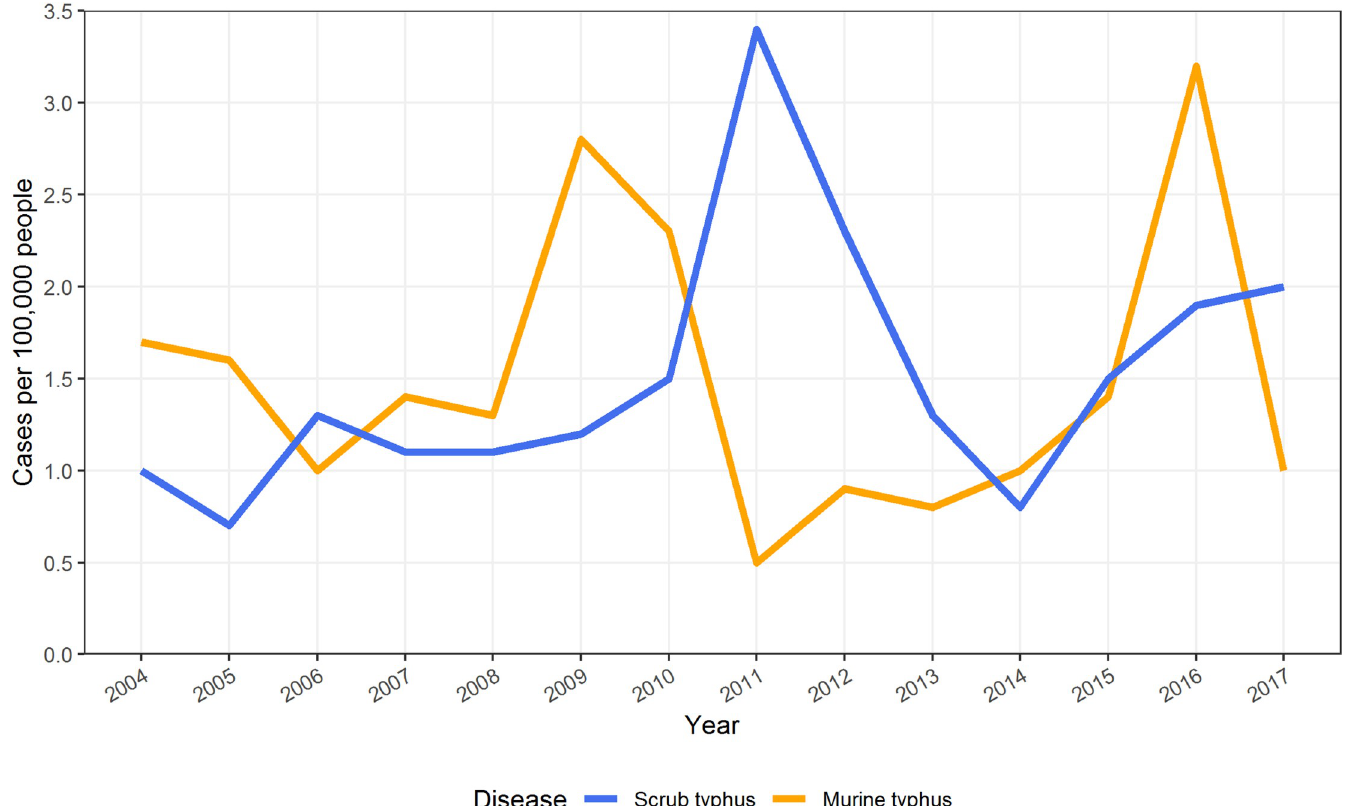
Fig 3. Yearly incidence of scrub typhus and murine typhus in Laos between 2004 and